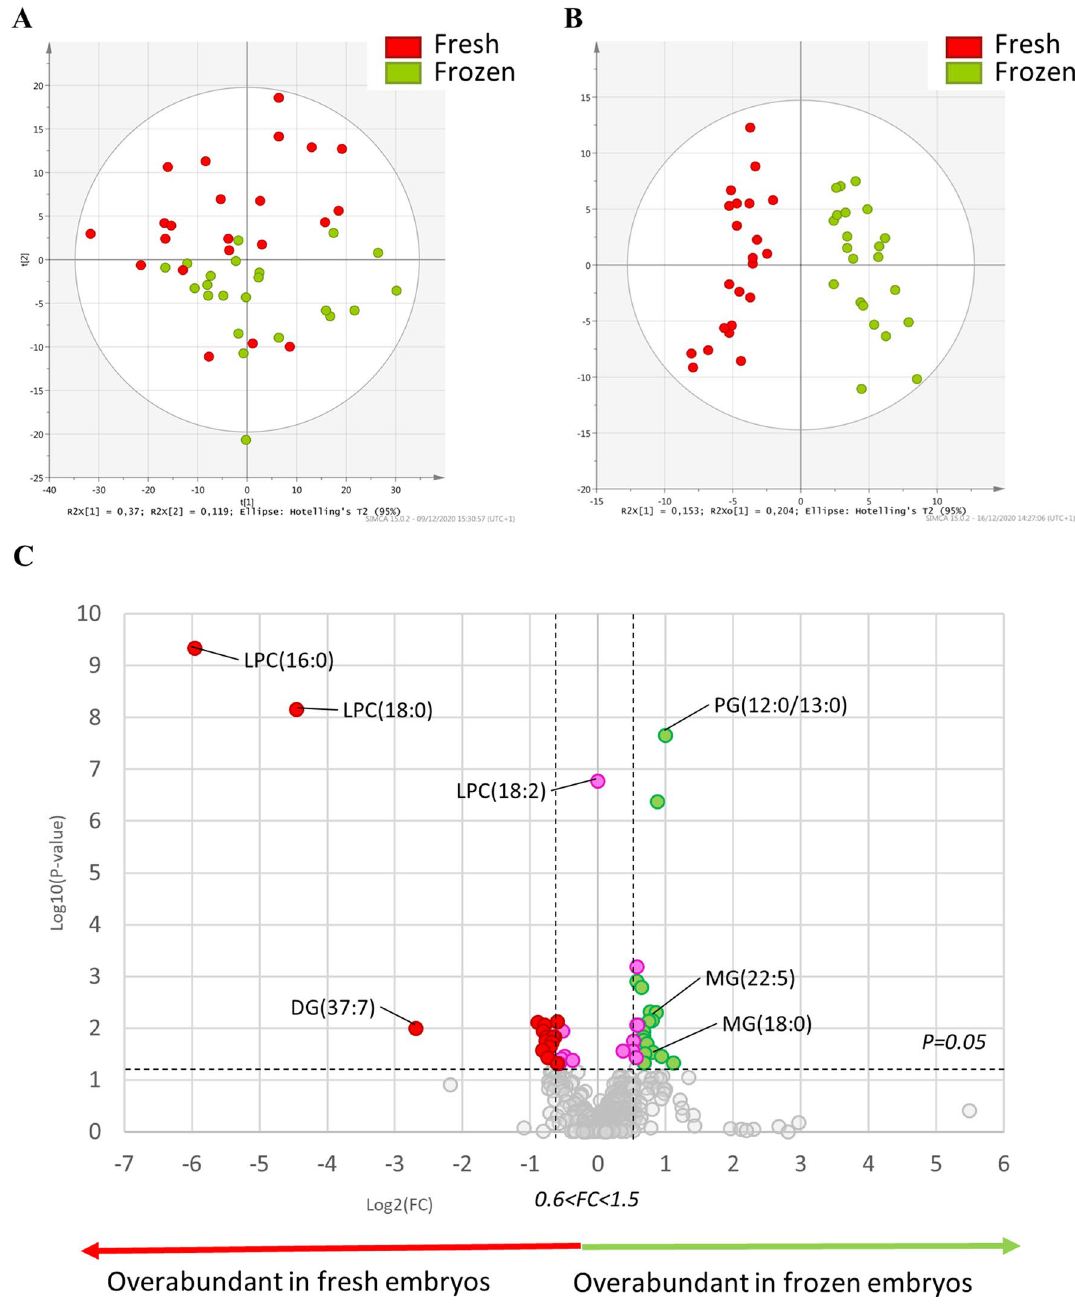
Figure 3. ( A ) Principal component analysis (PCA) plot representing variance among in vivo fresh and frozen embryos according to principal component analysis. The red dots show data for fresh in vivo produced embryos, and the green dots show data for frozen in vivo produced embryos. ( B ) Multivariate analysis by orthogonal partial least square discriminant analysis (O-PLS-DA), discriminating the state before and after freezing ( fresh vs. frozen ) according to the lipid profile of the embryos. ( C ) Univariate analysis via volcano plot based on fold- change and p value, highlighted several lipids. Red and green dots correspond to significantly different lipids between fresh and frozen in vivo produced embryos. Pink dots correspond to lipids with significant p values but a fold-change between 0.66 and 1.5. All the lipids to the right of this area are over abundant in the frozen in vivo produced embryos (green dots), while those on the left of the grey area are overabundant in the fresh in vivo produced embryos (red dots). Statistical significance is determined at p < 0.05 and fold-change greater than 1.5 or less than 0.66. Significantly different annotated lipids are represented on the volcano plot by the following abbreviations, lysophosphatidylcholine (LPC), phosphatidylglycerol (PG), monoacylglycerol (MG) and diacylglycerol